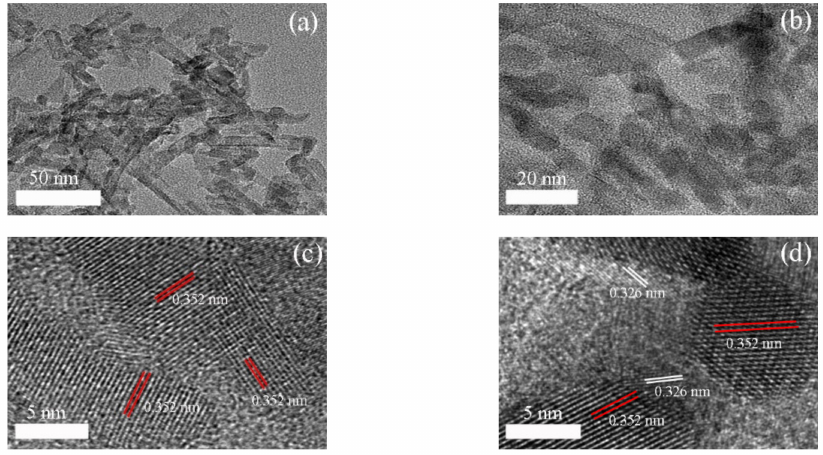
Figure 2. TEM images of TiO 2 ( a ) and g-C 3 N 4 /TiO 2 ( b ); HRTEM images of TiO 2 ( c ) and g-C 3 N 4 /TiO 2 ( d ).